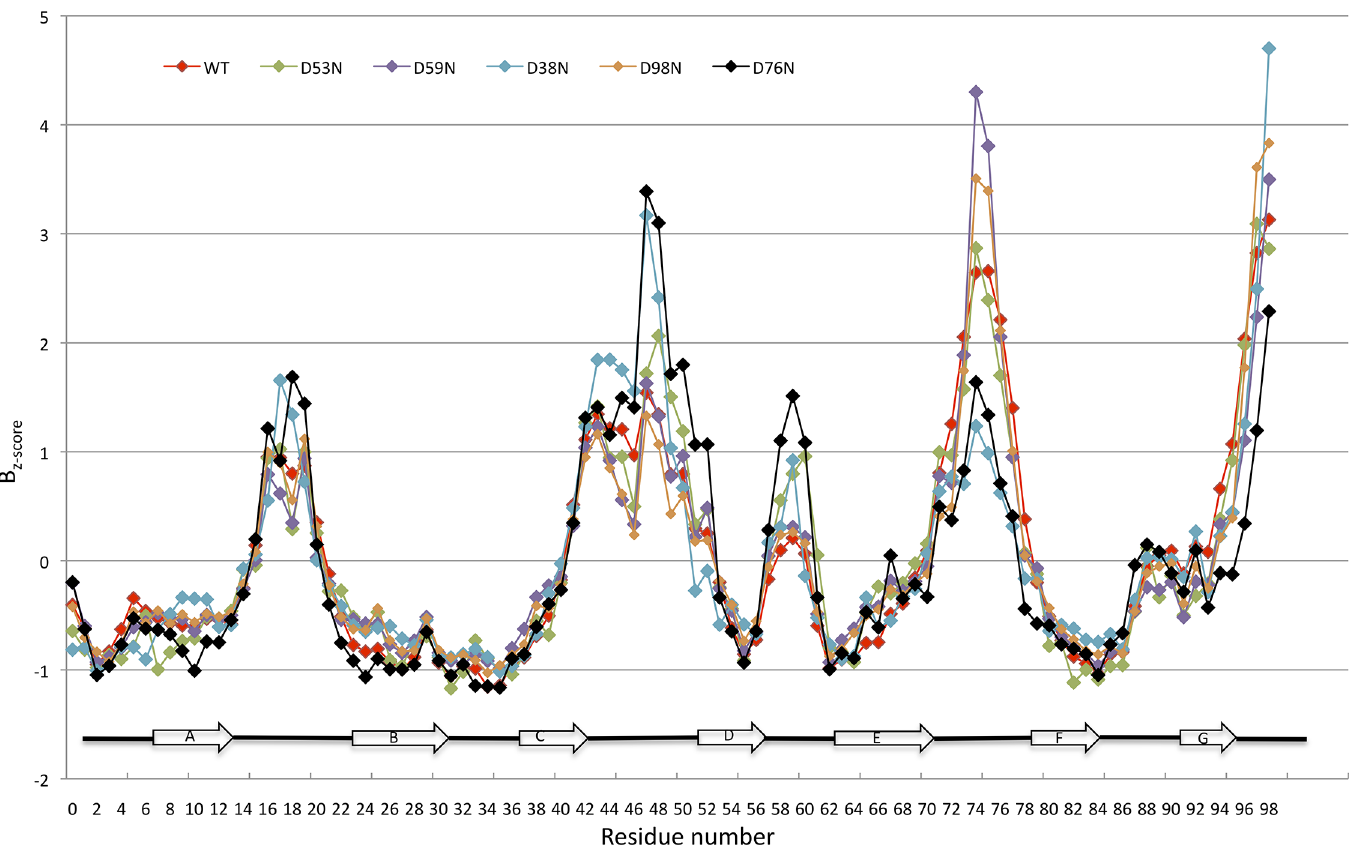
Fig 6. Comparison of the B z-score profiles for wt β 2m and four D-to-N mutants. Plot of the B z-score versus the residue number. Data for wt β 2m (red, pdb ID 2YXF), D76N (black, pdb ID 4FXL), D38N (cyan), D53N (green), D59N (purple), and D98N (orange) are presented. β -strands building up the β 2m fold are shown as arrows, and labelled in the lower part of the